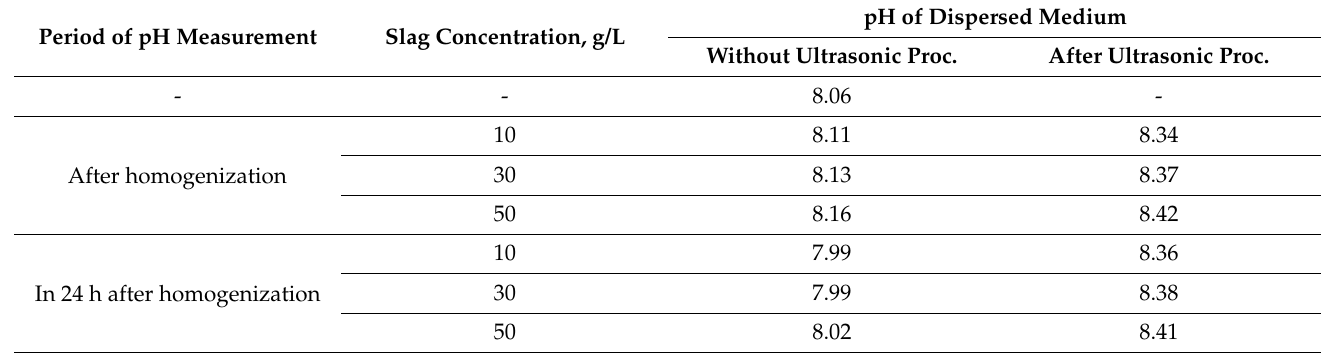
Table 15. pH values of the dispersed medium in water-polymer slag suspensions. pH of Dispersed Medium Period of pH Measurement Slag Concentration, g/L Without Ultrasonic Proc. After Ultrasonic